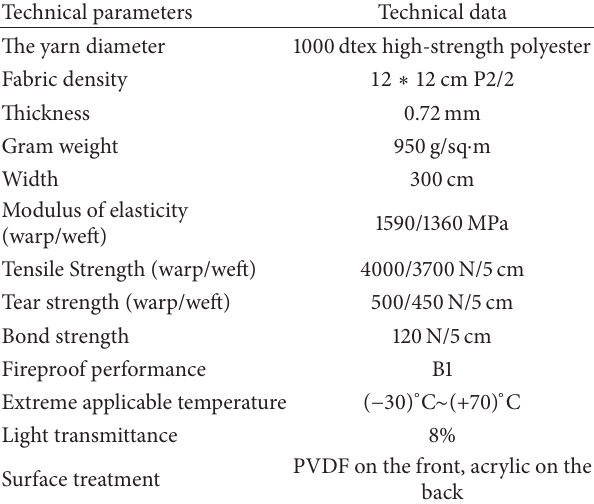
Table 2: The material parameters of the ZZF 3010